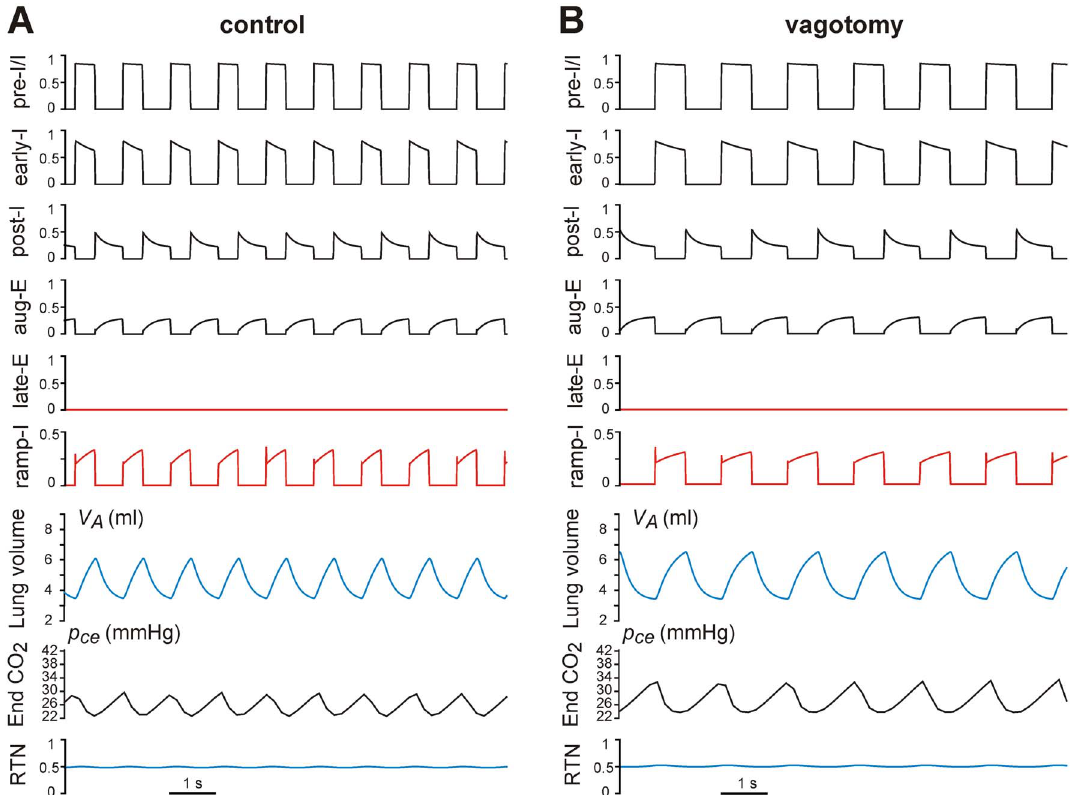
Figure 2. Model performance in control conditions (A) and after vagotomy (B). The top 6 traces in A and B represent output activity (normalized firing rate) of the corresponding neurons. The bottom two traces represent the end capillary blood p c ( p ce ) just before the next heart beat and the RTN drive, respectively. Note that vagotomy (removal of mechanical feedback) prolongs inspiration and expiration, increases the amplitude of ramp-I (and hence PN) activity and lung inflation (maximal lung volume and tidal volume), and slows the respiratory